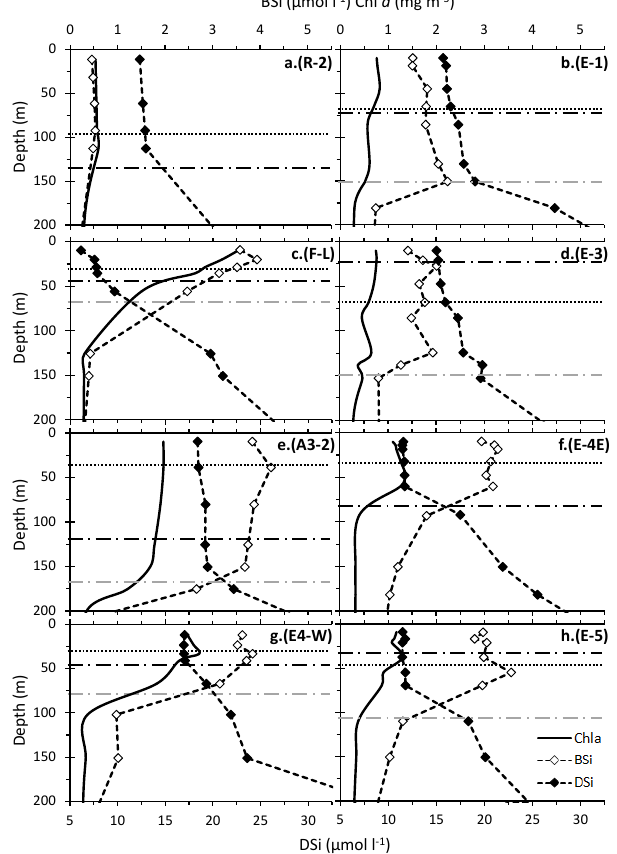
Figure 3. Vertical distribution of chlorophyll a (solid black line; estimated from CTD fluorescence), biogenic silica concentration ([BSi], light dots) and H 4 SiO 4 concentration ([DSi], dark dots). Dotted lines show the bottom of the euphotic layer (1% of pho- tosynthetically active radiation, Ze) for each station. Dark dashed lines represent the mixed layer depth (MLD; estimated by Park et al., 2014) and grey dashed lines correspond to a second density gra- dient identify from the density CTD